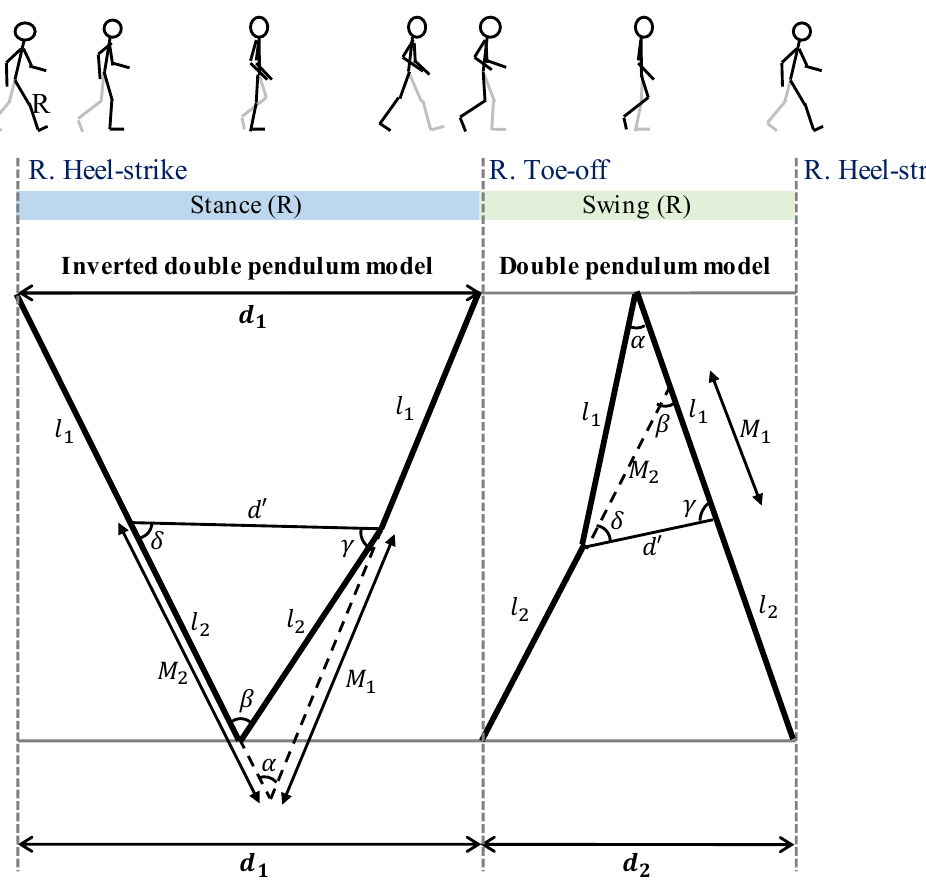
Figure A2. Graphical summary of the double pendulum model (adapted from Aminian et al. [42]) used for estimating the stride lengths from sagittal angular velocity (rad/s) data of the right shank and right thigh during right stance and swing phases